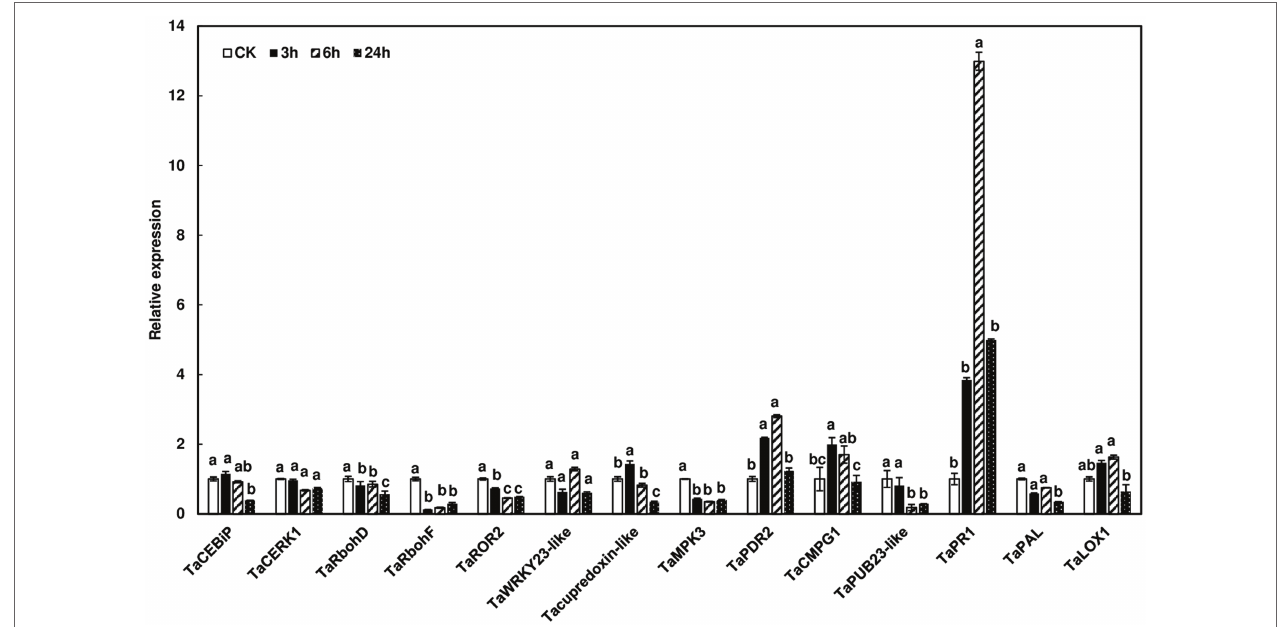
FIGURE 6 | Induction of defense marker genes in wheat heads in response to F. graminearum infection. Wheat heads from Norm were dip-inoculated with PH-1 at a concentration of 10 5 conidia/ml in .02% Tween 20. Wheat heads were collected at 0, 3, 6, and 24 hpi. Gene expression was determined by RT-qPCR. Wheat gene glyceraldehyde-3-phosphate dehydrogenase ( TaGAPDH ) was used as an internal control for transcript normalization. Fold changes of gene expression were relative to control samples. The mean of expression for each gene was calculated and compared by one-way ANOVA and Tukey’s HSD post-hoc test using JMP15 ( n = 3; p < .05). Different letters indicate significant